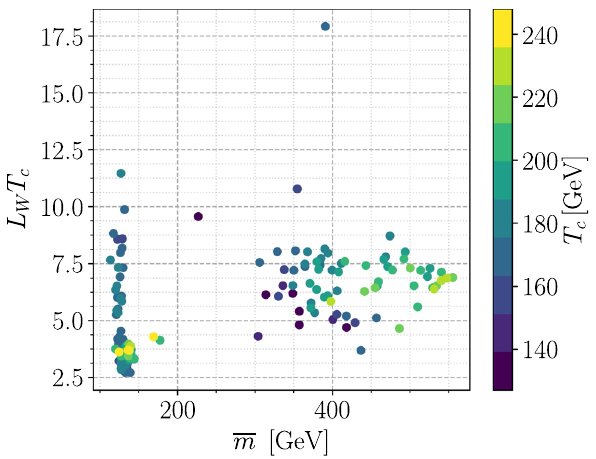
Fig. 5 L W T c versus the average mass scale m (definition, see text) for the allowed C2HDM TI and TII parameter points. The colour code denotes the critical temperature T